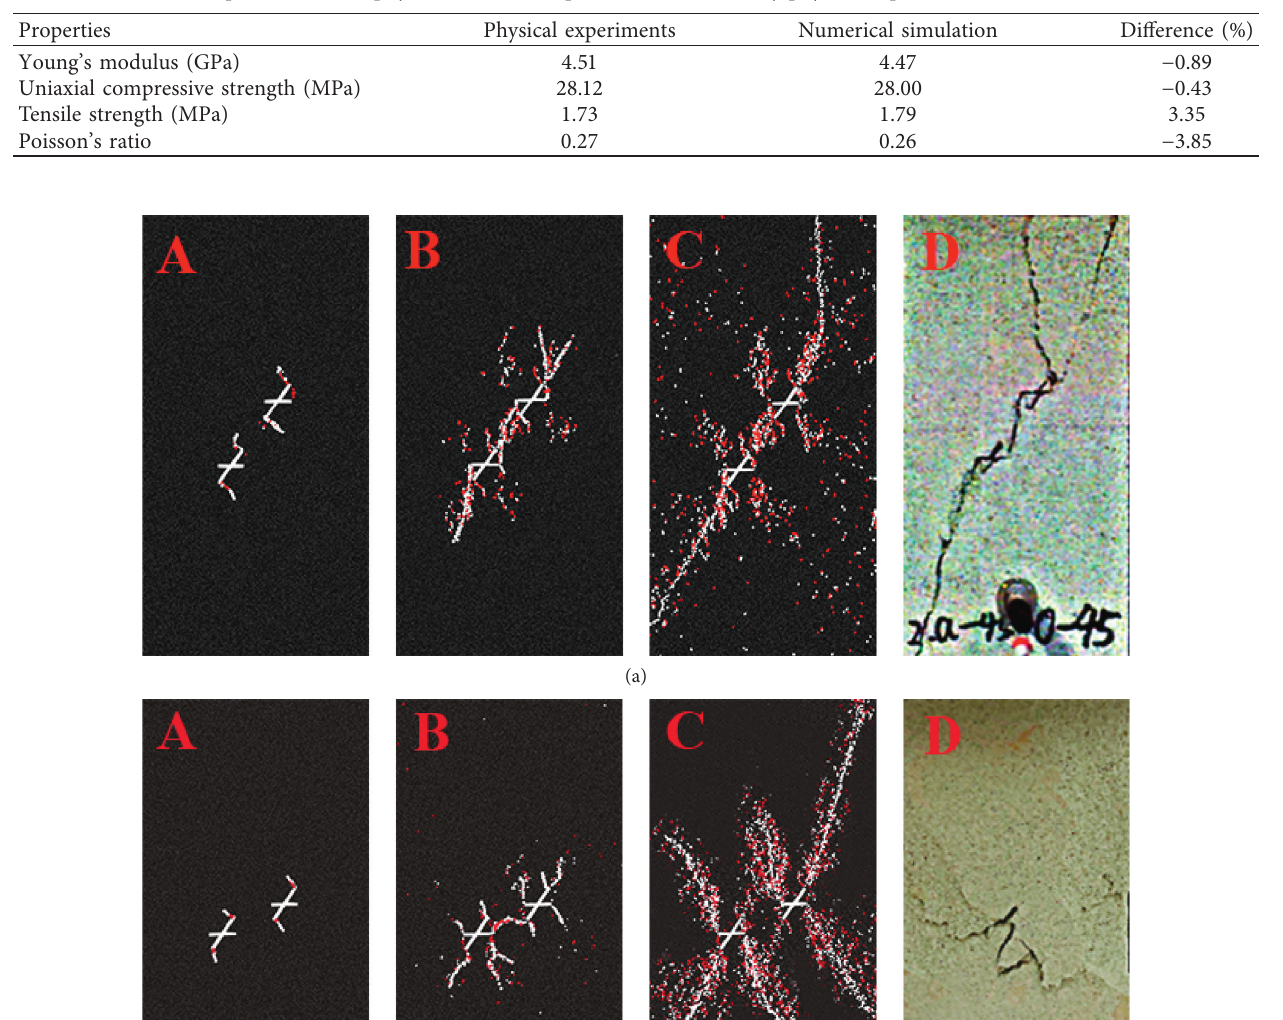
Table 4: Comparison of rock physical-mechanical parameters obtained by physical experiments and FJM simulation.